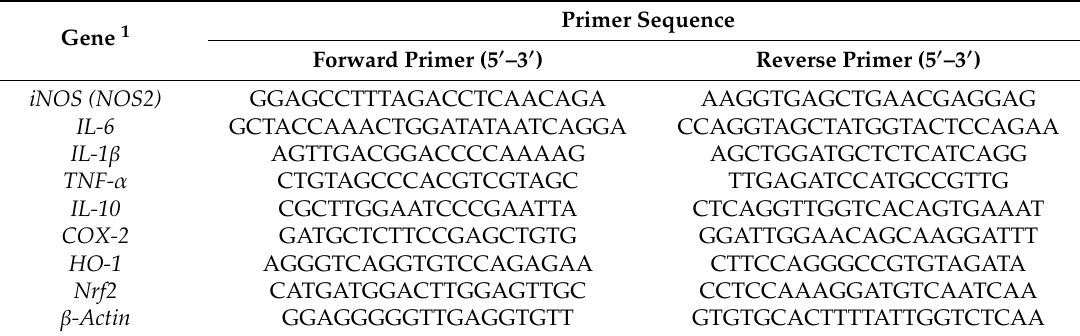
Table 1. Primers used for qRT-PCR